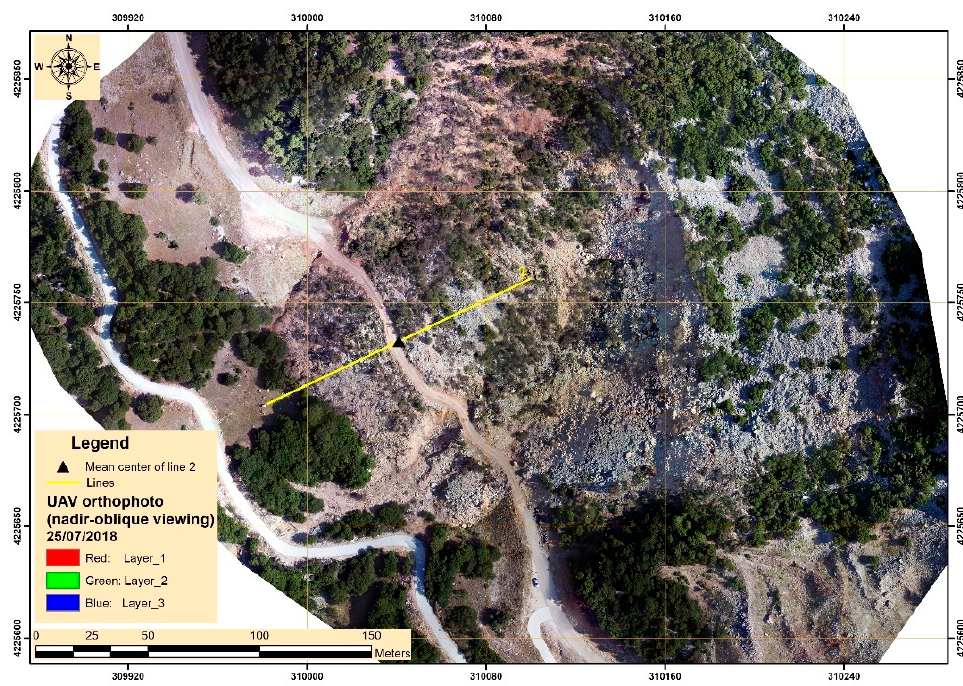
Figure 8. Location of mean center of line 1.